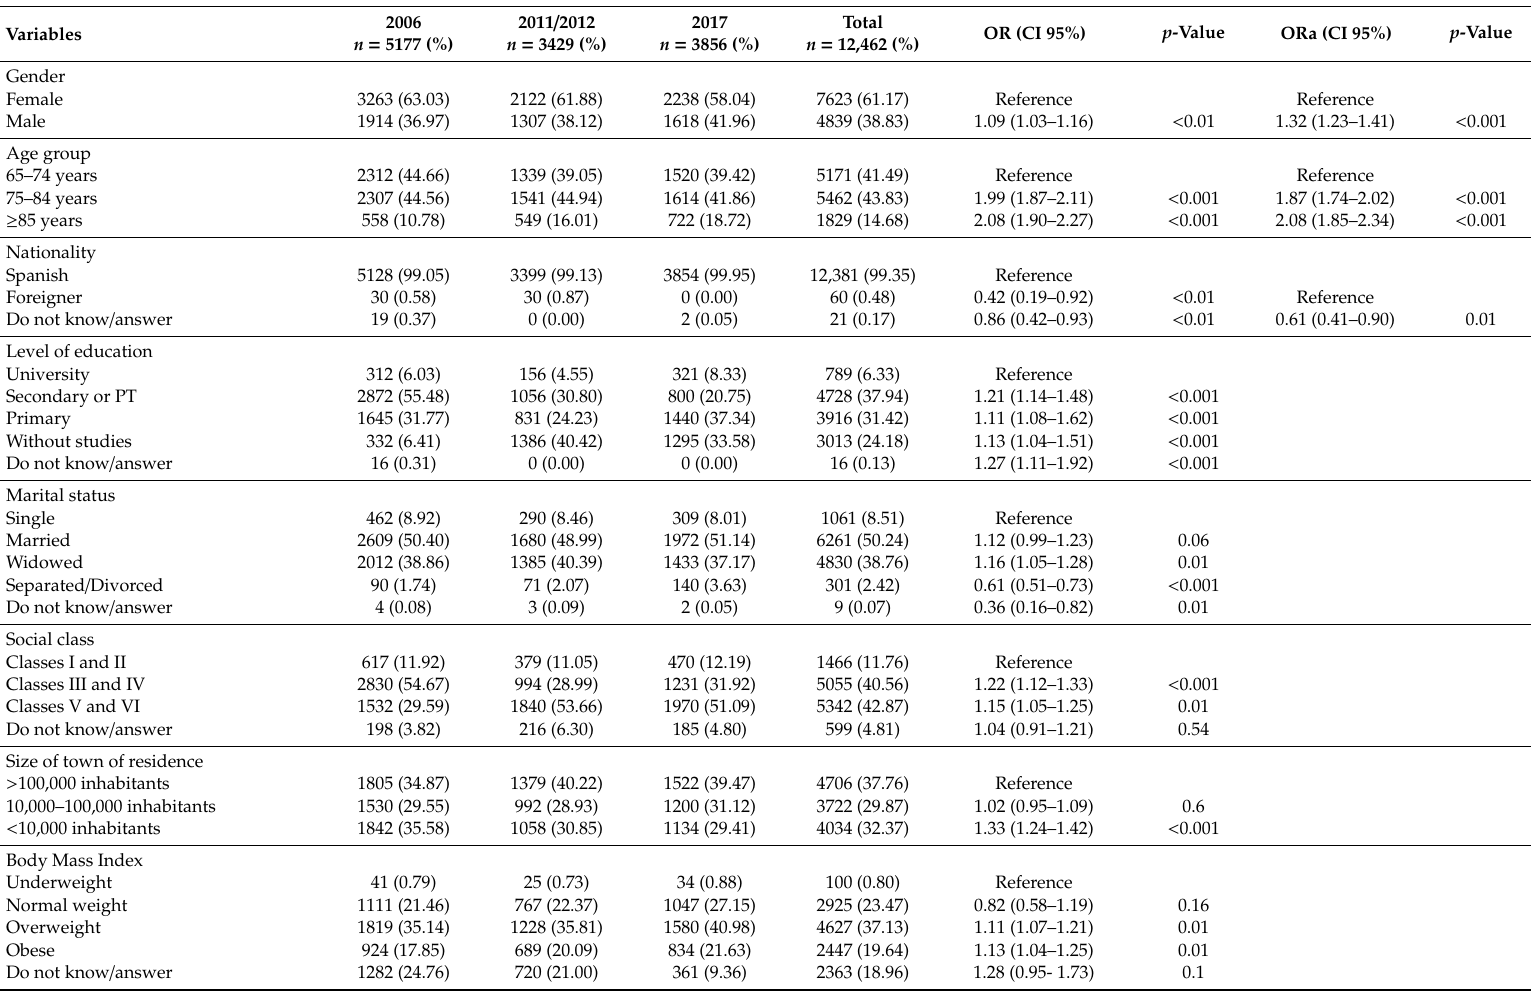
Table 2. Association between participation in the influenza vaccination campaign, sociodemographic and health-related variables in people aged ≥ 65 years in Spain. Spanish National Health Surveys